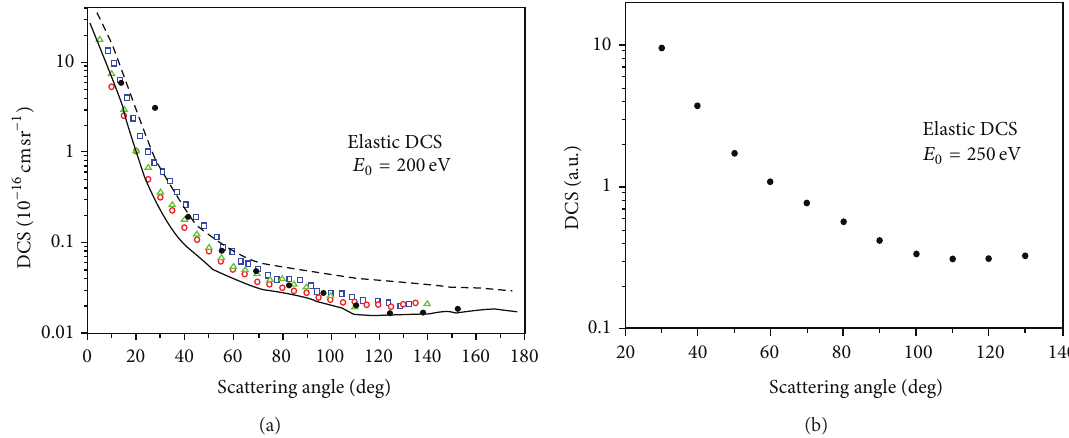
Figure 18: DCSs for elastic e-CH 4 collision at (a) 200 eV and (b) 250eV. Full circles present our experimental results; open circles, experimental data of Iga et al. [90]; open squares, experimental data of Vuskovic and Trajmar [72]; open triangles, experimental data of Sakae et al. [99]; solid line, theoretical results of Iga et al. [90]; dashed line, theoretical results of Dhal et al.